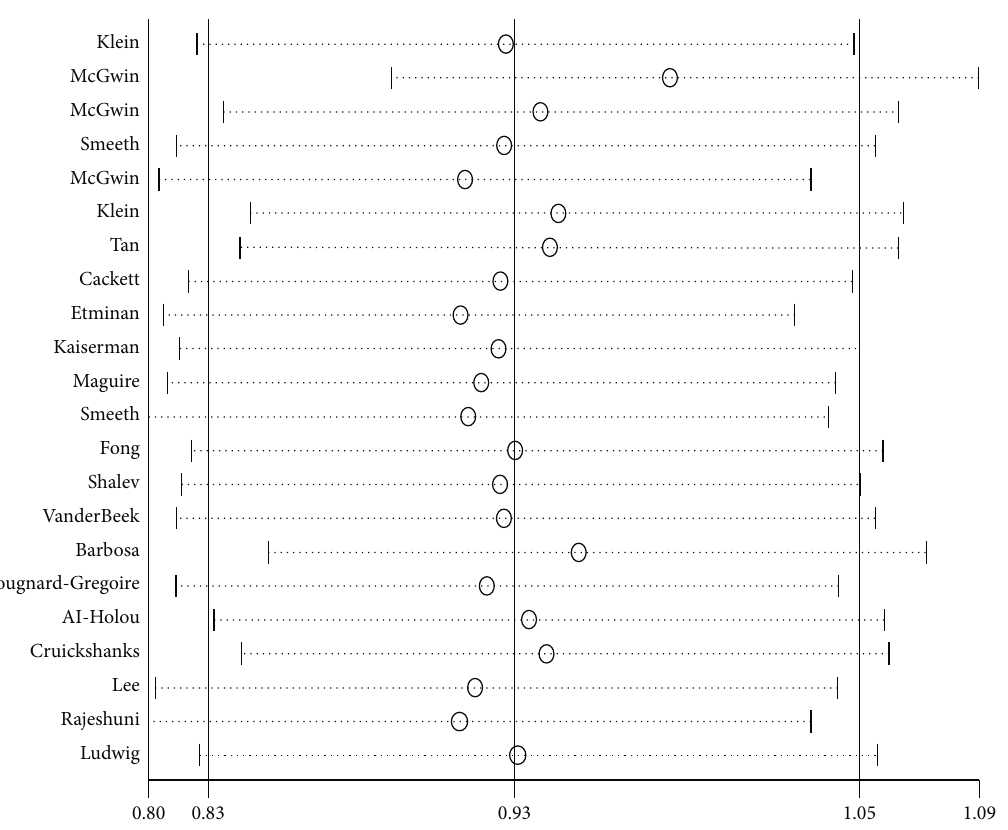
Figure 3: Sensitivity analysis for the assessment of the relationship between statin consumption and risk of developing AMD.